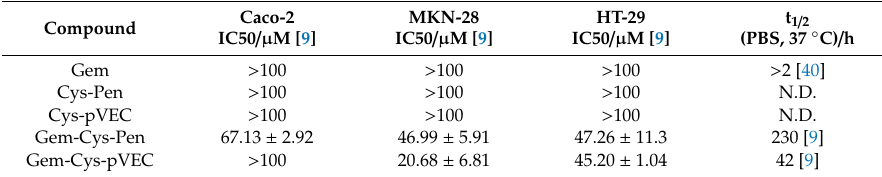
Table 4. Biological activity and half-life of the studied